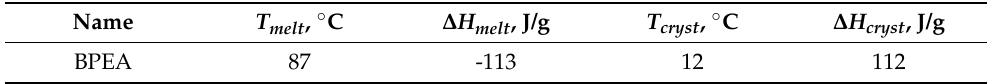
Figure 4. DSC thermogram of a PVC composition containing BPEA .